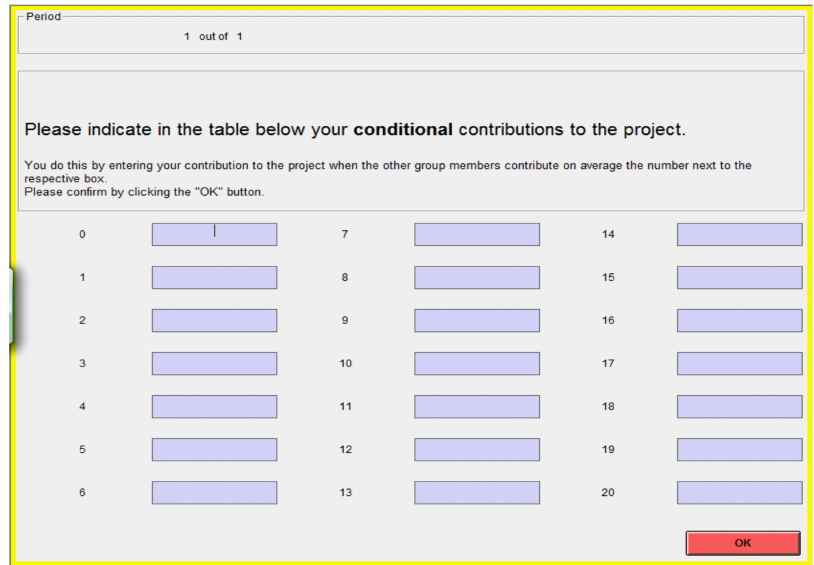
Figure A1. Contribution table in the ORDERED treatment (same as in